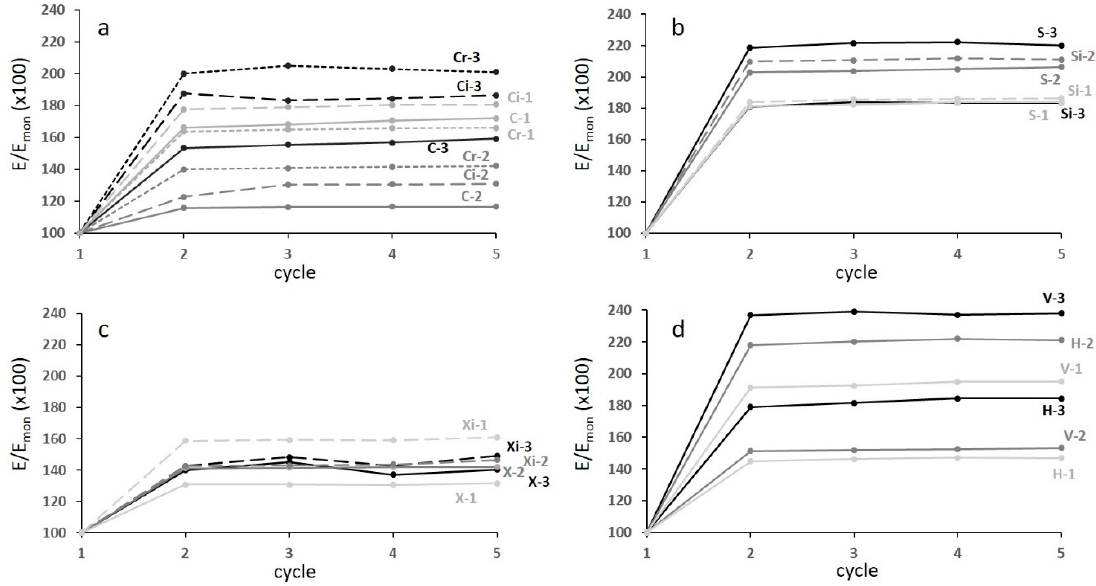
Figure 9. The evolution of the normalized Young’s modulus during cyclic tests. The letters refer to structures and numbers to batches. ( a ) Cubic, ( b ) star, ( c ) cross, ( d ) hexagon and